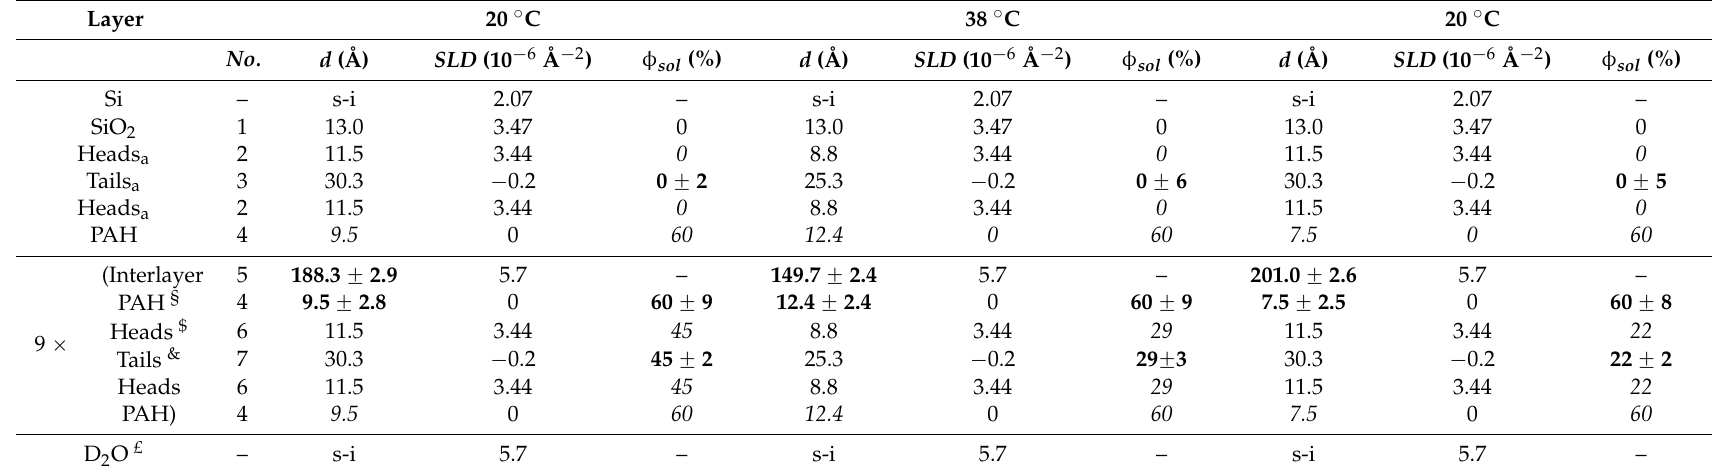
Table 1. Structural parameters of sample A incubated with PAH-58 in D 2 O (3